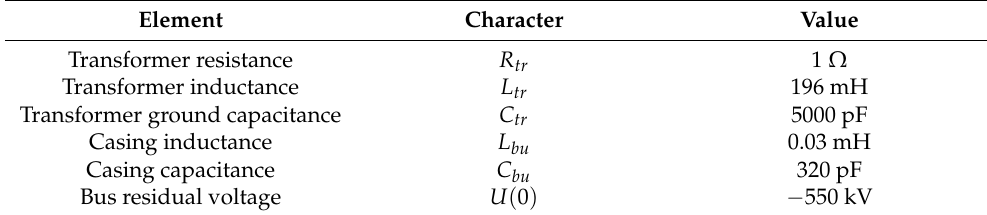
Table 1. VFTO simulation model component parameters.